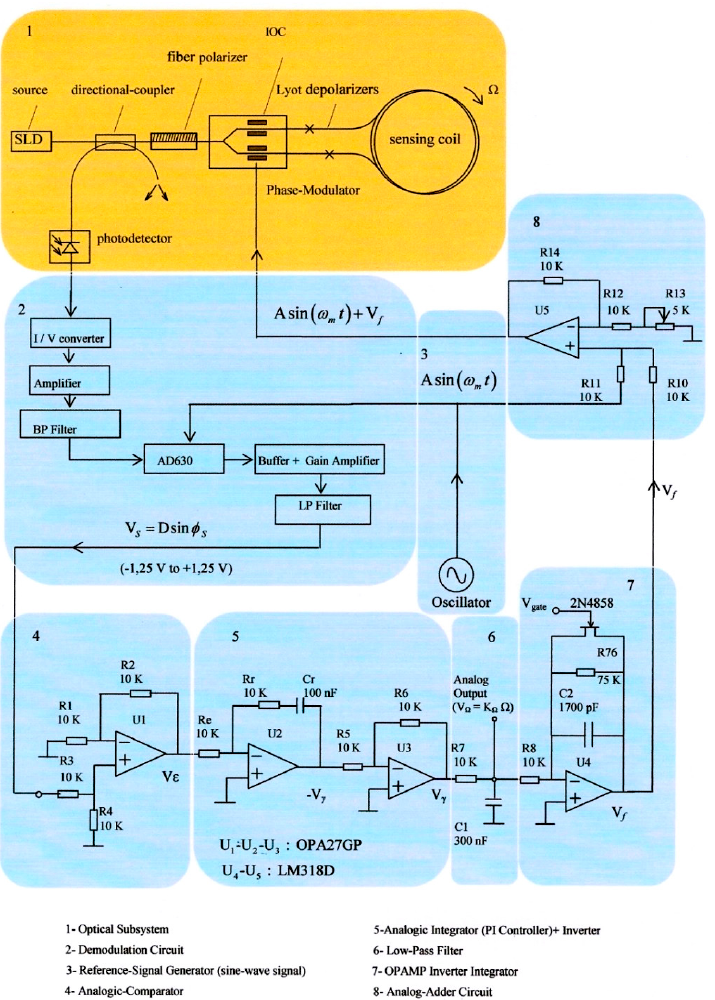
Figure 3. Primary block-diagram configuration of electro-optical and Phase-Sensitive-Demodulation (PSD) systems. The model is closed-loop configuration with sinusoidal bias phase-modulation and serrodyne feedback phase-modulation.